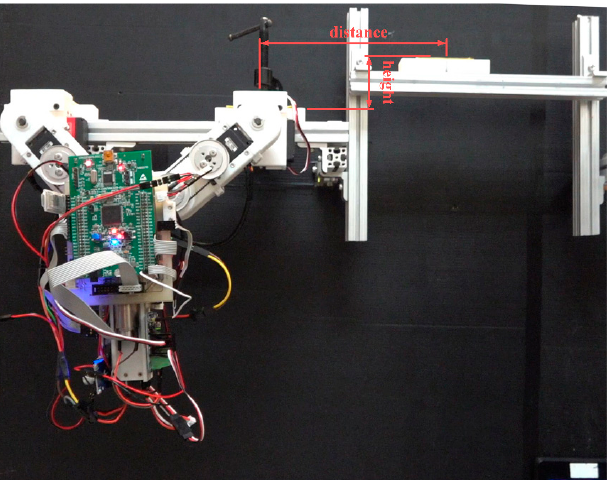
24 of 29 Figure 21. Experimental results: joint motion in Experiment (f). 6.2. Experiment: Non-Horizontal-Elevation Ledge Brachiation The first set of experiments described above demonstrated the feasibility of the pro- posed motion control strategy when dealing with a target that is level with the starting point. Our next goal was to assess the feasibility of the proposed motion control strategy when dealing with a target that is higher than the starting point. As shown in Figure 22,